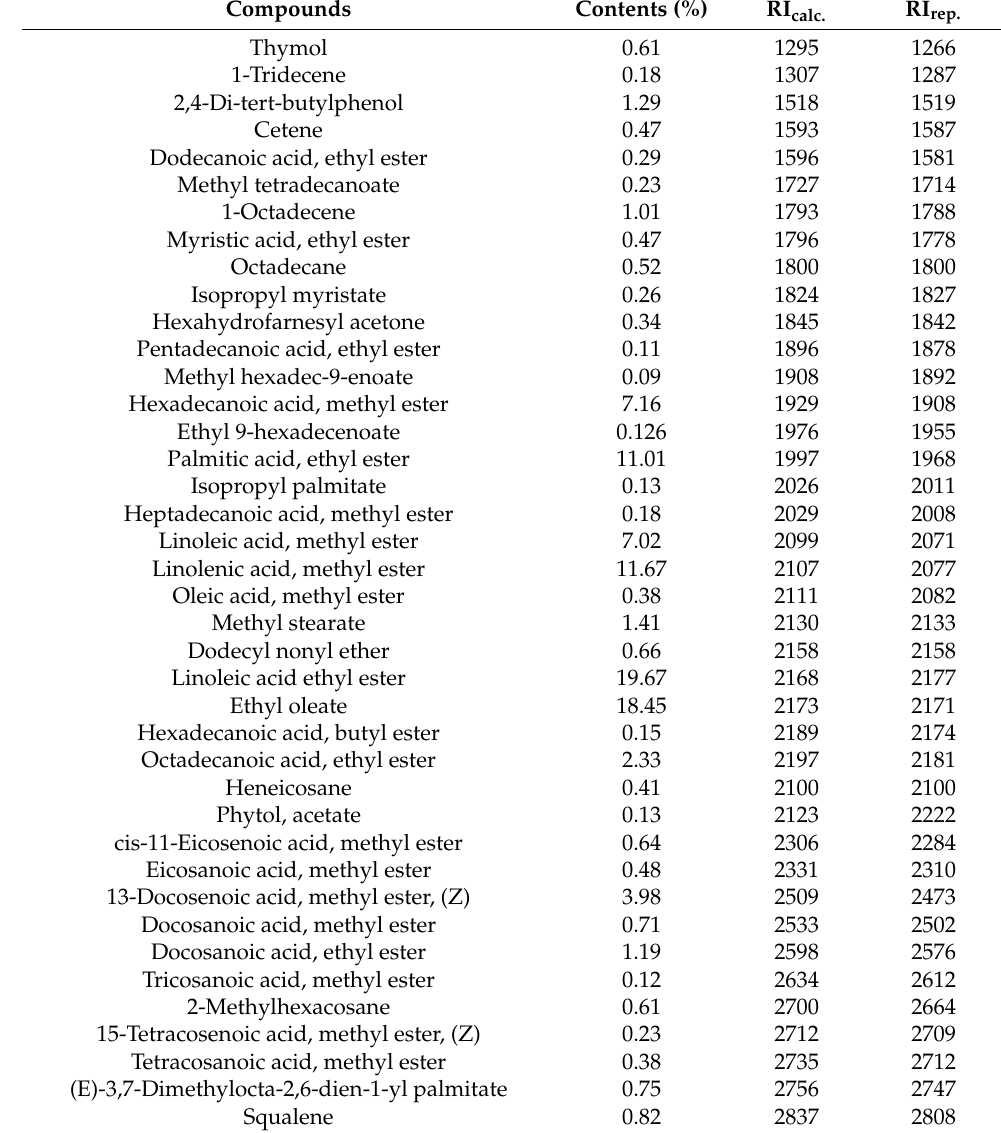
Table 1. Identification of compounds by GC-MS analysis in the oils of S. edelbergii